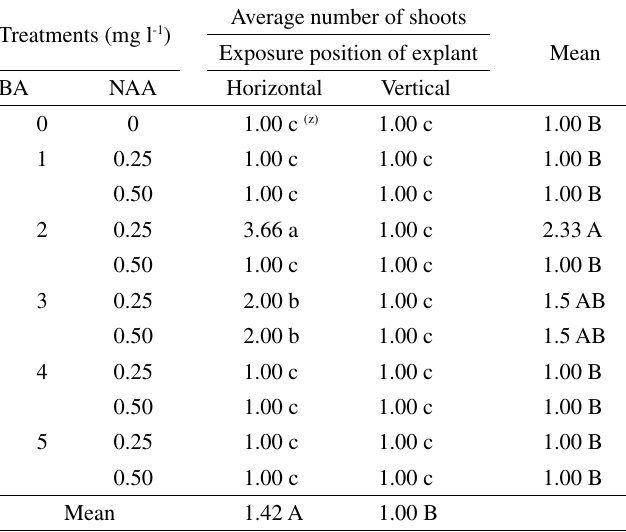
Table 7 - The interaction effect of different concentrations of BA and NAA, and exposure position of explants on the shoot prolif- eration rate in